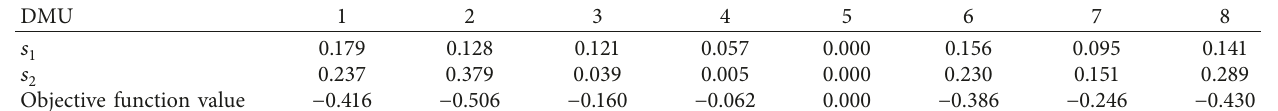
and S calculated by the model ( D 1 2